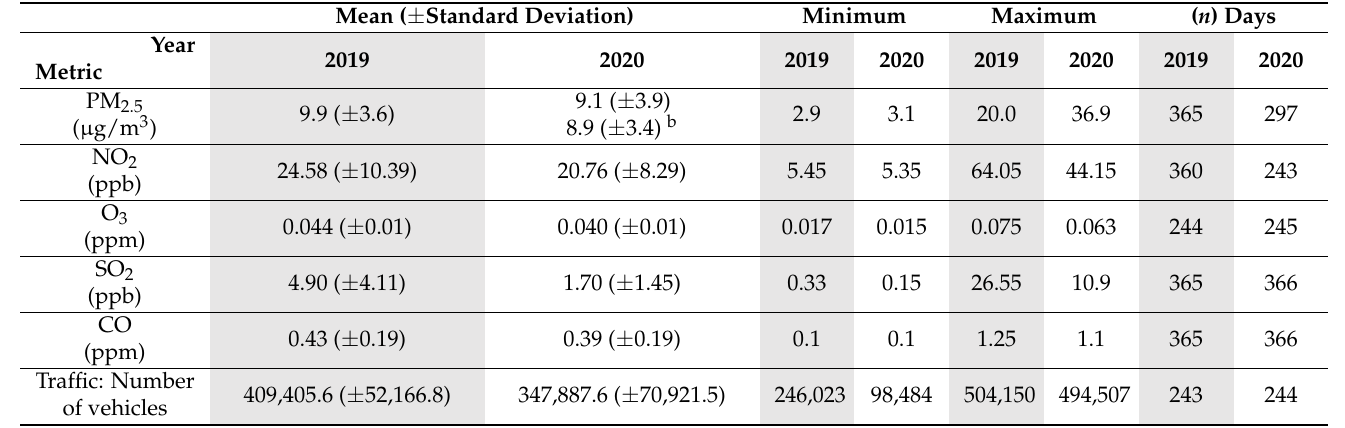
Table 2. Descriptive statistics of air pollutant concentrations (of interest in this study) and traffic volumes in 2019 and 2020 in Birmingham, Alabama.